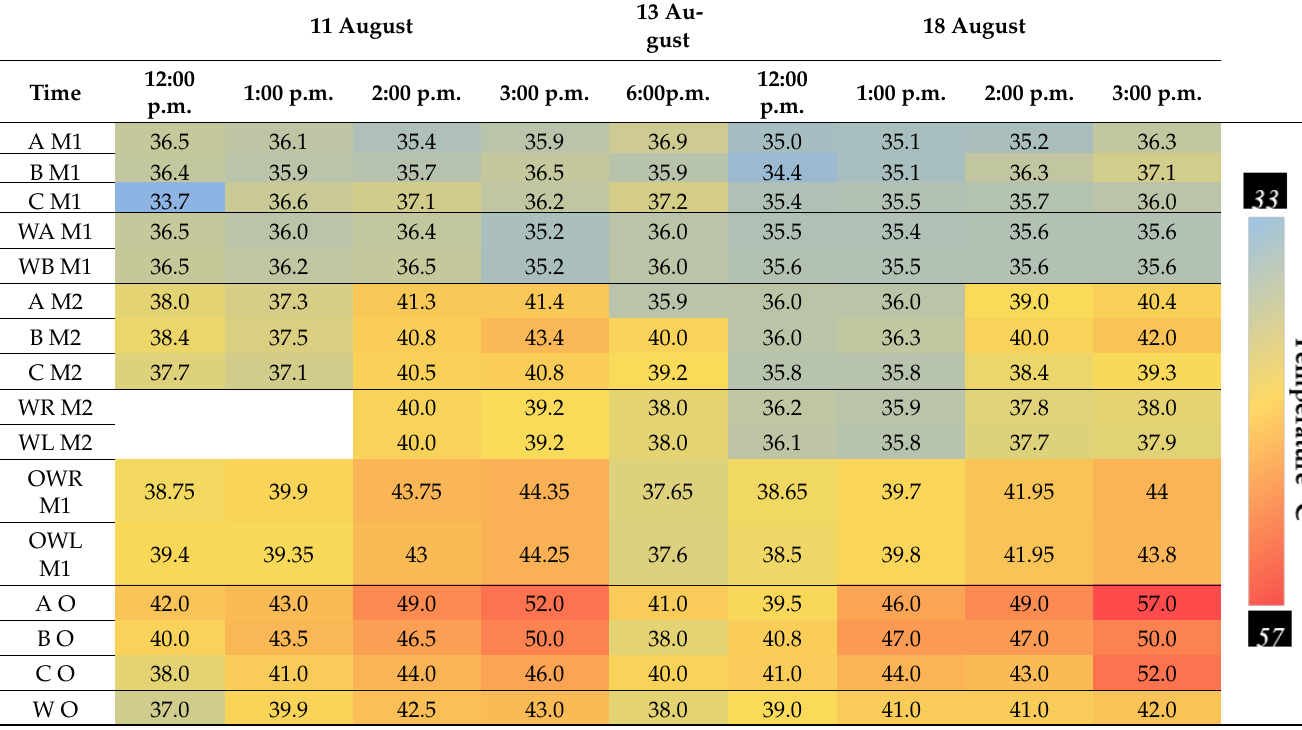
Figure 18. Interior measurement zones on the mashrabiya and abbreviated names.